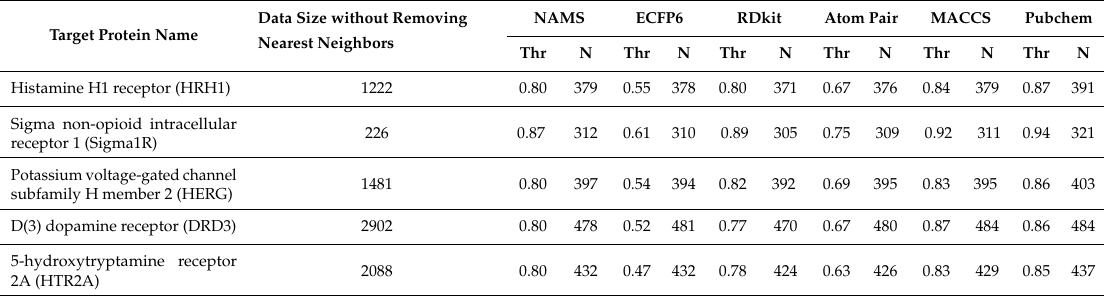
Table 2. Data size before and after removing nearest neighbors. Thr—similarity threshold; N—new data set